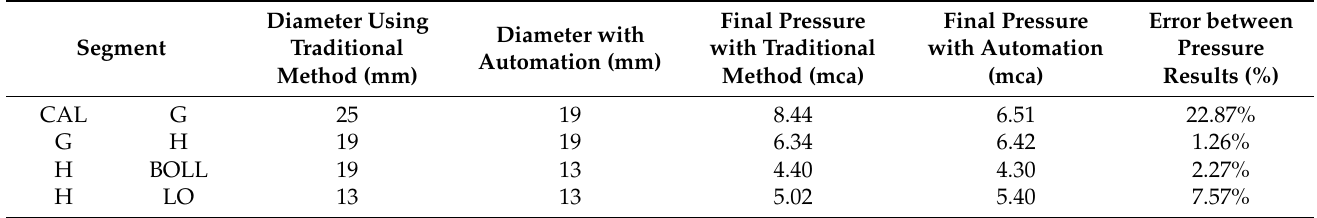
Table 25. Comparisons of hot-water network final diameter and pressure for type 2 retail